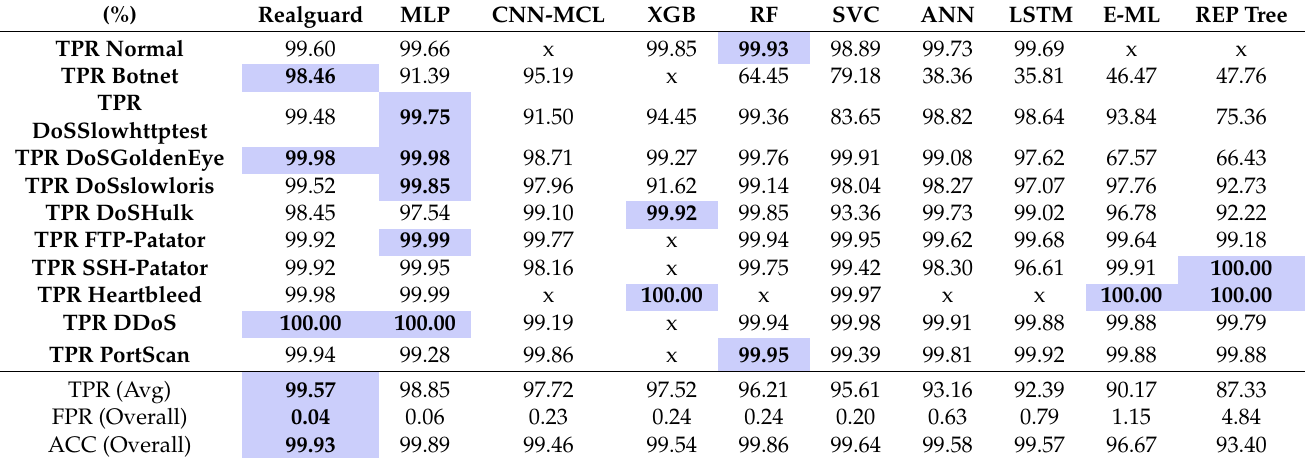
Figure 6. Comparing the FPR value of the multi-class attack detection between Realguard and its competitors. Table 5. Details of comparing multi-class attack detection quality between Realguard and its